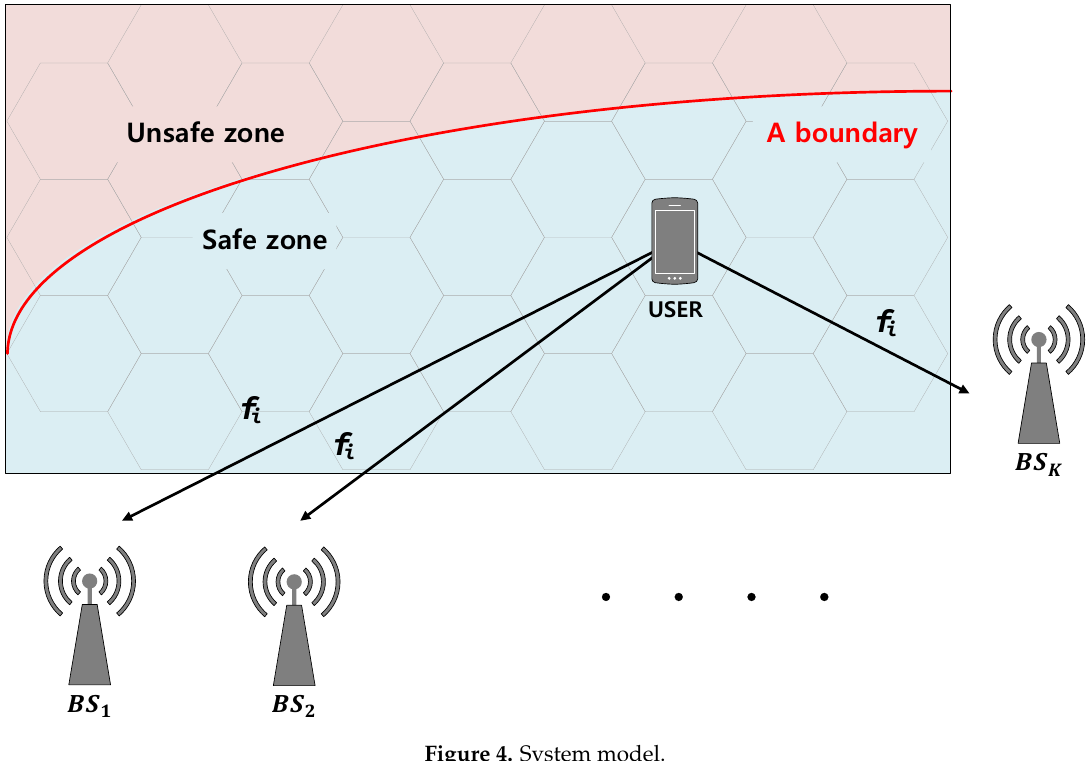
Figure 4. System